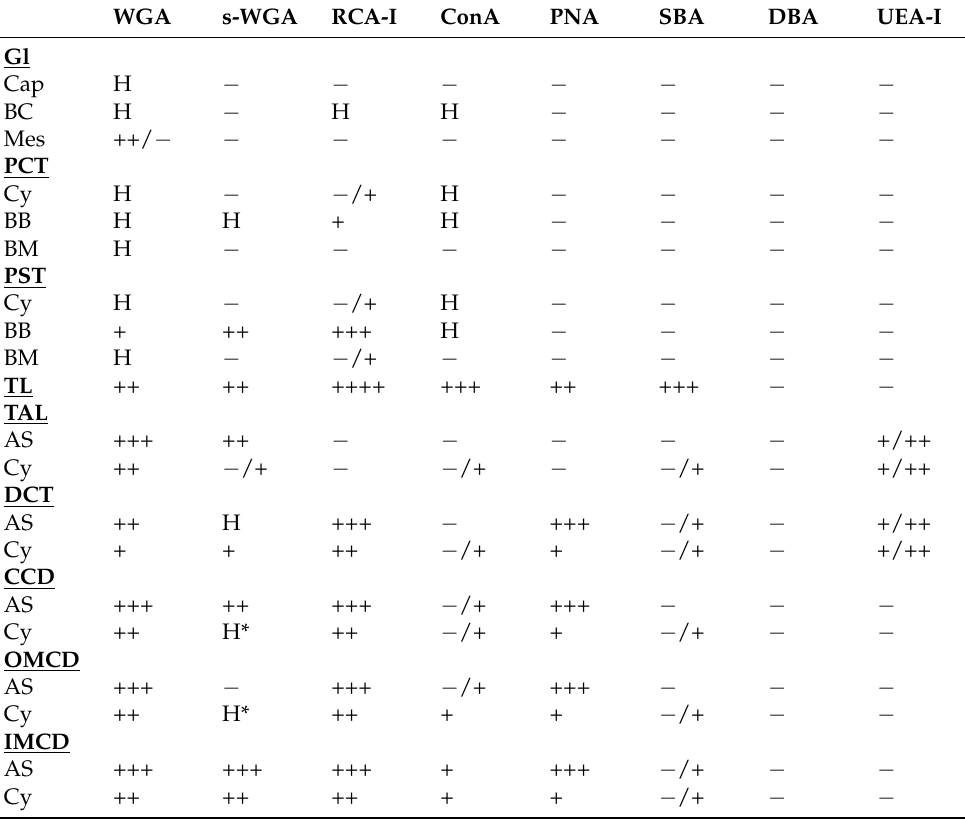
Table 2. Lectin binding patterns in feline kidneys.